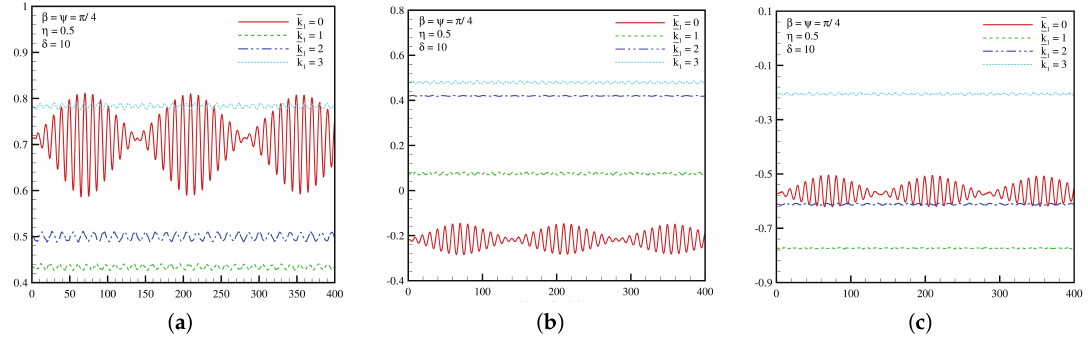
Figure 16. Normalized magnitude of position vector in ( a ) b 1 ; ( b ) b 2 ; ( c ) b 3 directions vs. normalized time for ¯ k 1 = 0, 1, 2, 3; β = ψ = π rad; δ = 10; and η = 0.5 [32]. 4